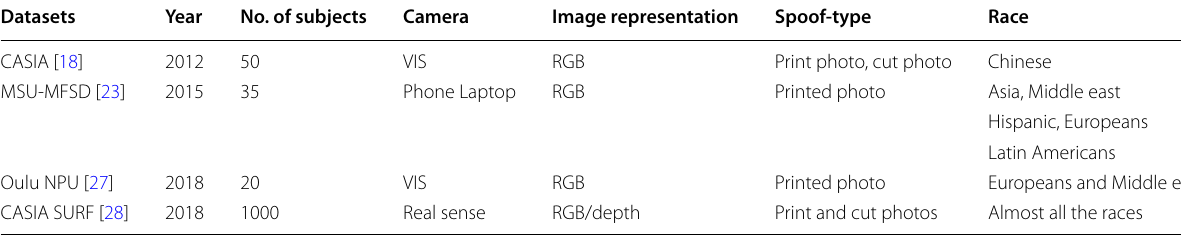
Table 1 Selective face anti-spoofing datasets and related parameters